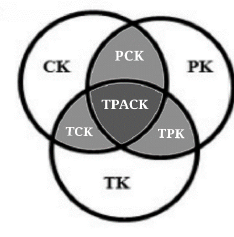
Figure 1: Seven Components of